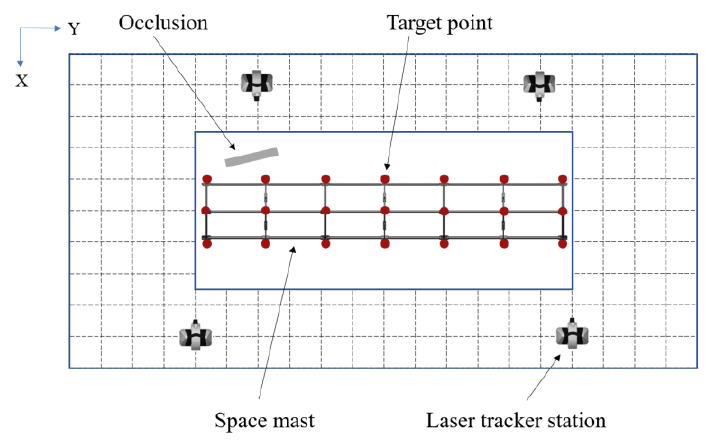
Figure 6. Simulated layout measurement field.